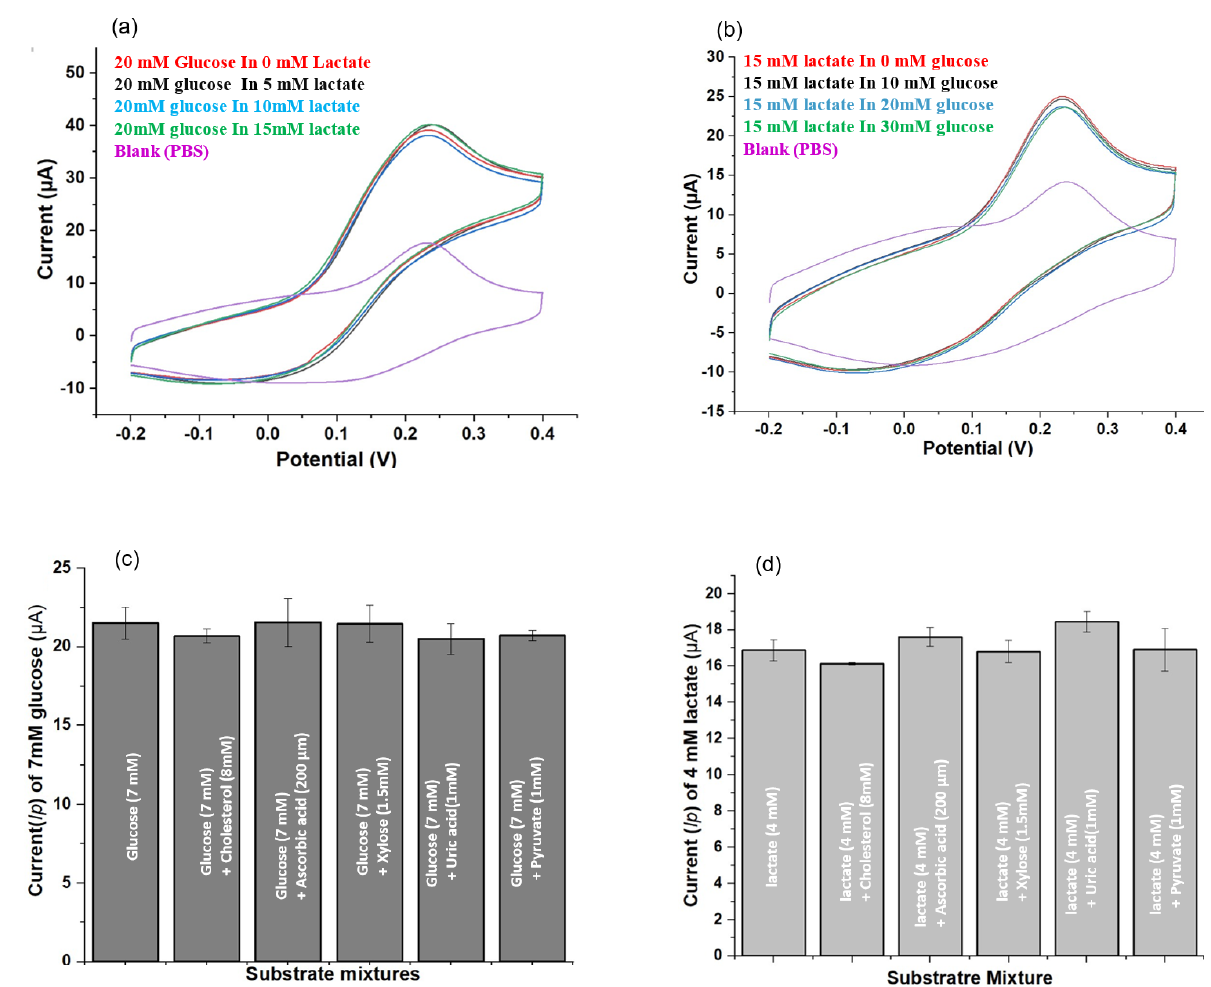
Figure 3. Selectivity test: ( a ) CV responses for 20 mM glucose in different lactate solutions (0 mM, 5 mM, 10 mM, and 15 mM). ( b ) CV responses for 15 mM lactate in different glucose solutions (0 mM, 10 mM, 20 mM, and 30 mM). ( c , d ) Bar graph representation of the mean I p for 7 mM glucose and 4 mM lactate prepared in a separate mixture of 8 mM cholesterol, 200 µM ascorbic acid, 1.5 mM xylose, 1 mM uric acid, and 1 mM pyruvate. All experiments were conducted on a double electrode sensor (GOX and LOX modified DWSPCEs).